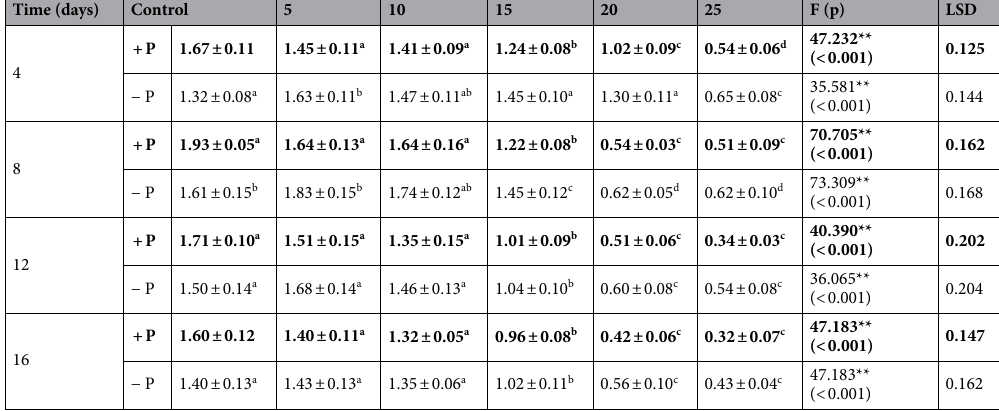
Table 4. Effect of different concentrations of dissolved nickel (mg/L) on respiration activity (O 2 -uptake calculated as µ mol O 2 h -1 ) on phosphorus supplemented and starved cells of Dunaliella tertiolecta . F F test (ANOVA), LSD least significance difference at 0.05. *Statistically significant at p ≤ 0.05. **Statistically significant at p ≤ 0.001. Different superscripts are